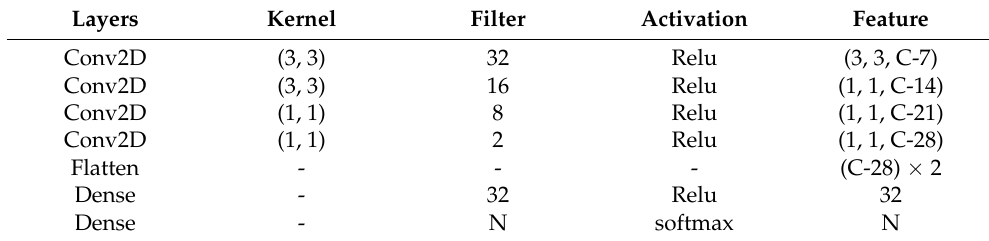
Table 3. The structure of the basic CNN